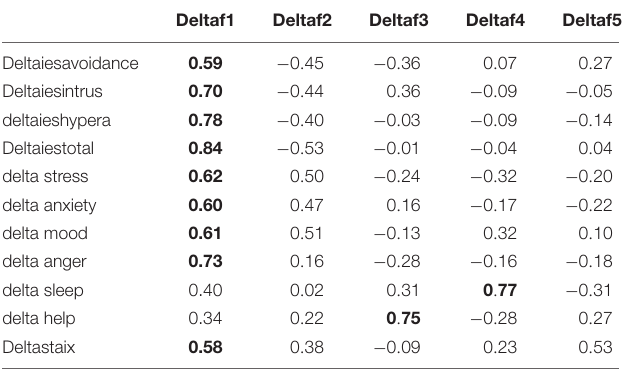
TABLE 2 | PCA on delta variables (IES and Thermometer).